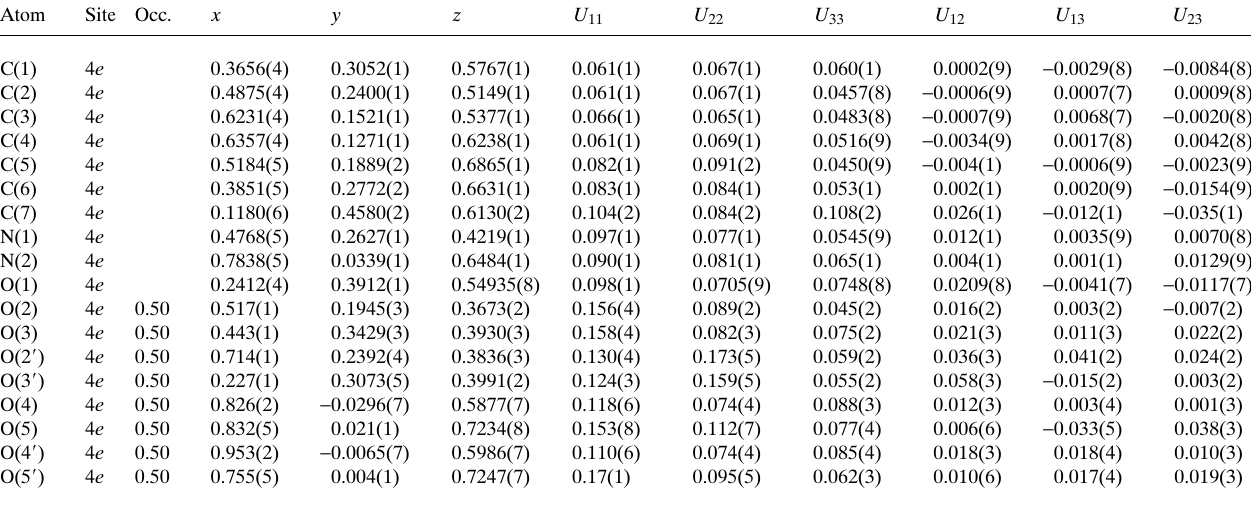
Table 3. Atomic coordinates and displacement parameters (in Å 2 ) .